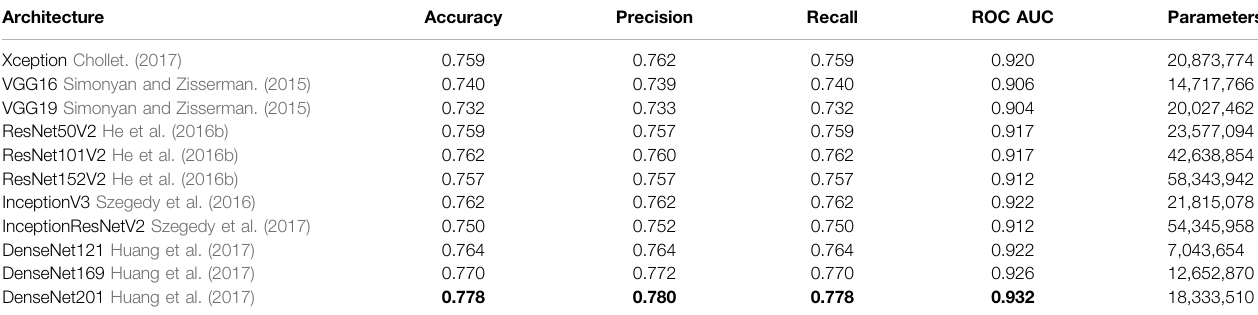
TABLE 1 | Metrics for different CNN architectures. Highlighted in bold are the best observed values. The last column indicates the total number of parameters for each architecture. Architecture